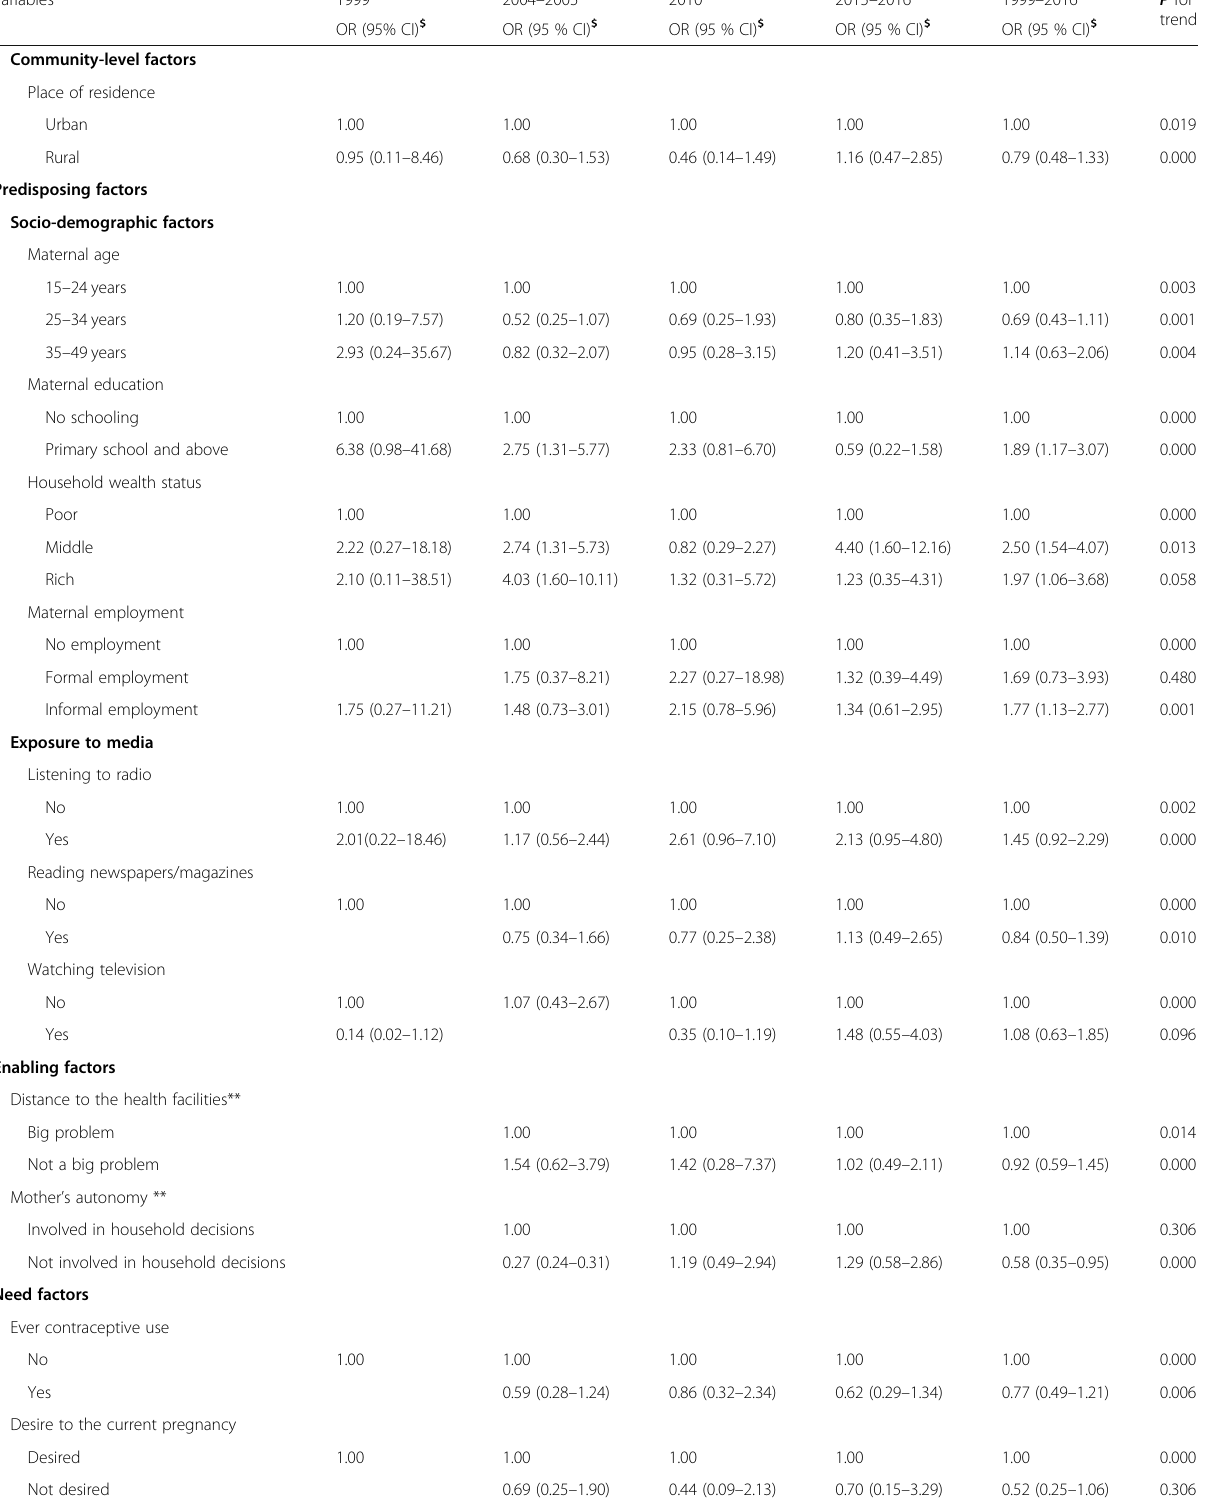
Table 4 Factors associated with 1 – 3 antenatal care visits in Tanzania, 1999 –